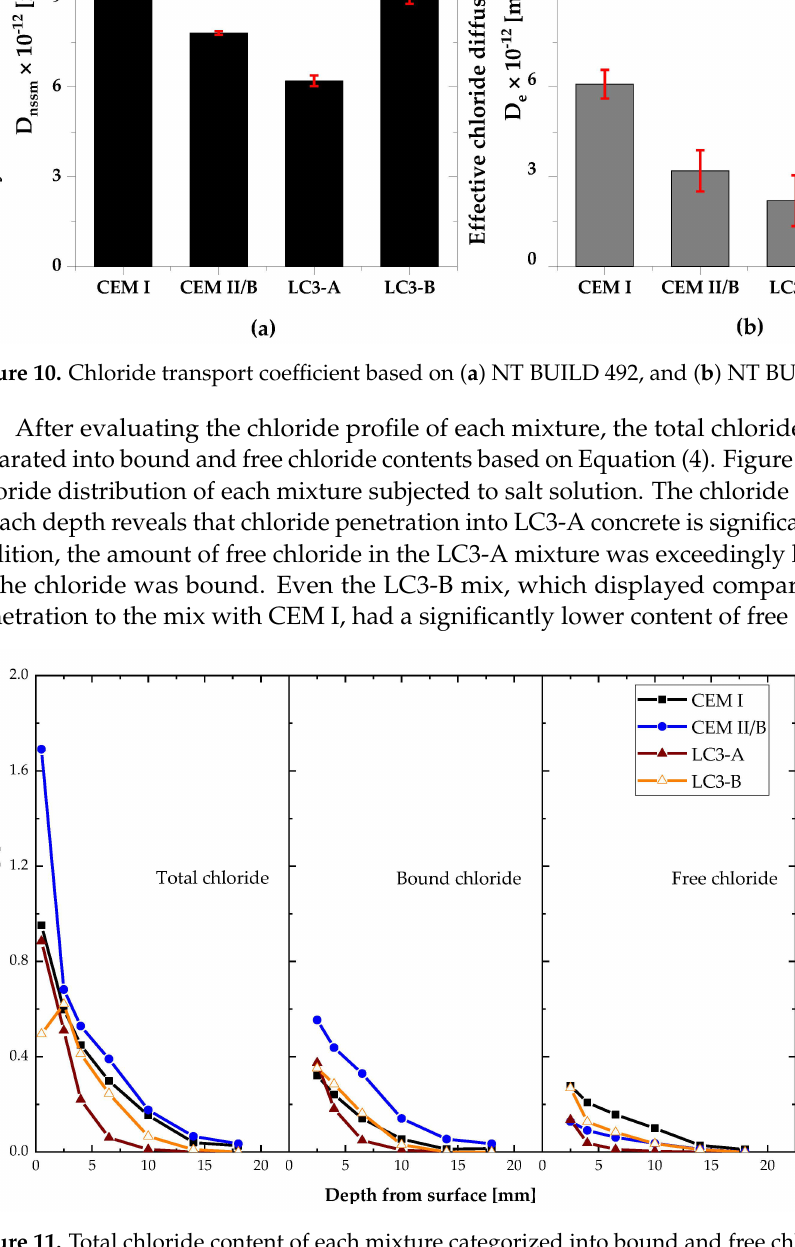
Figure 11. Total chloride content of each mixture categorized into bound and free chloride